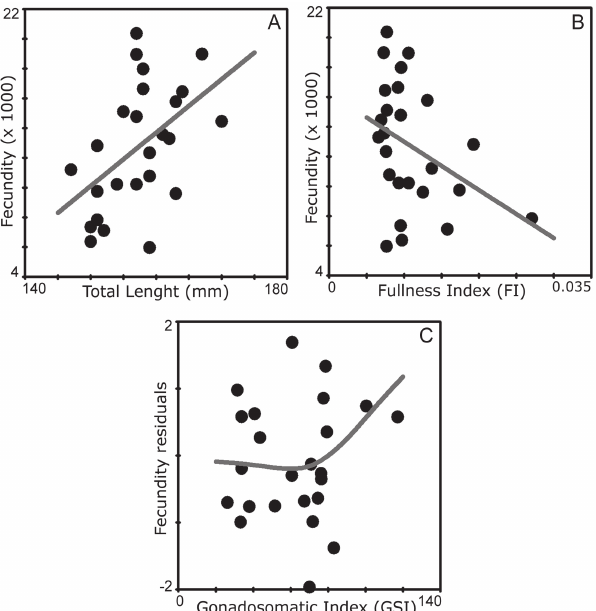
Fig. 10. Relation between fecundity with total length (A) and fullness index (B) and between fecundity residuals (after controlling for the length effect) with gonadosomatic index (C) for Cetengraulis edentulus in Guanabara Bay . Lines represent the generalized additive models selected by the Akaike information criterion.